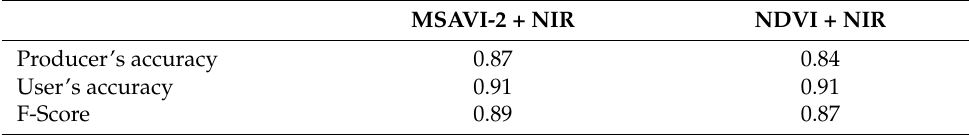
Table 7. User’s and producer’s accuracies and F-Score after merging